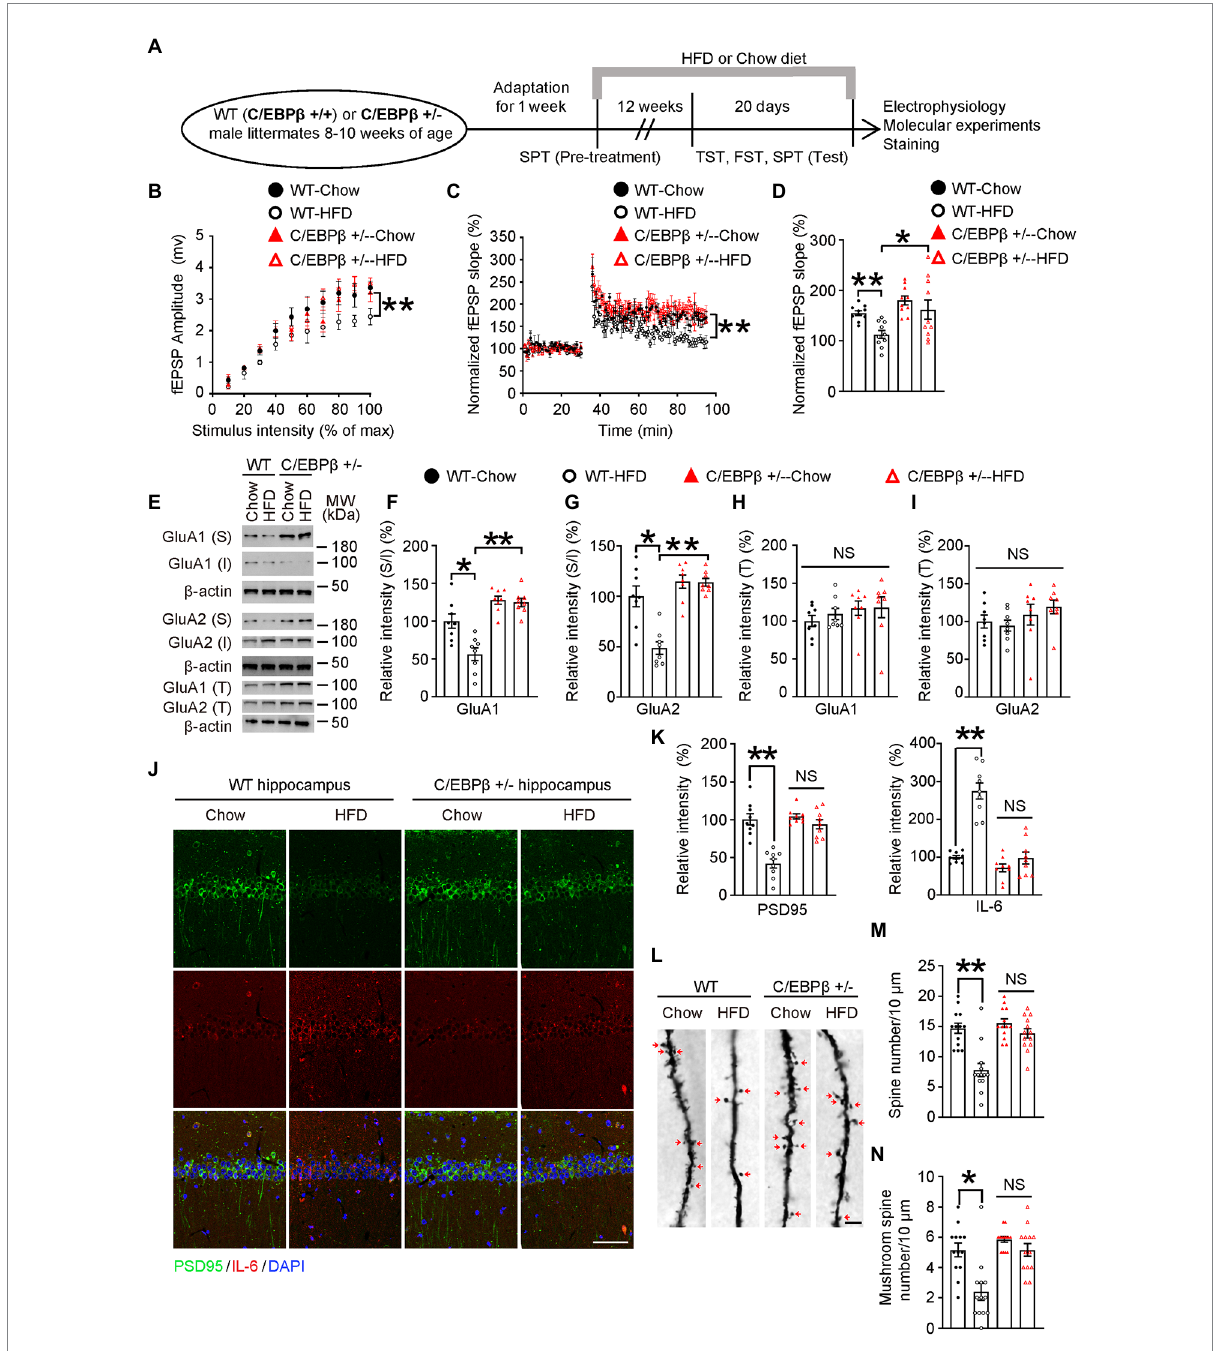
FIGURE 5 Genetic knockdown of CEBPB represses HFD-induced synaptic plasticity impairment and alleviates neuro-inflammation in the hippocampus. (A) Schematic of the HFD or chow diet course and behavioral tests process. (B) Input/output curves illustrating the relationship between the magnitudes of stimulation and evoked response for field excitatory postsynaptic potentials (fEPSPs) recorded in hippocampal slices from wild- type-Chow, wild-type-HFD, C/EBP β +/ − -chow and C/EBP β +/ − -HFD mice. Data represent the mean ± SEM ( n = 8–10 for each group; ** p < 0.01; two-way ANOVA and Bonferroni’s multiple comparison test). (C) LTP induced by HFD in hippocampal slices from different groups. Data